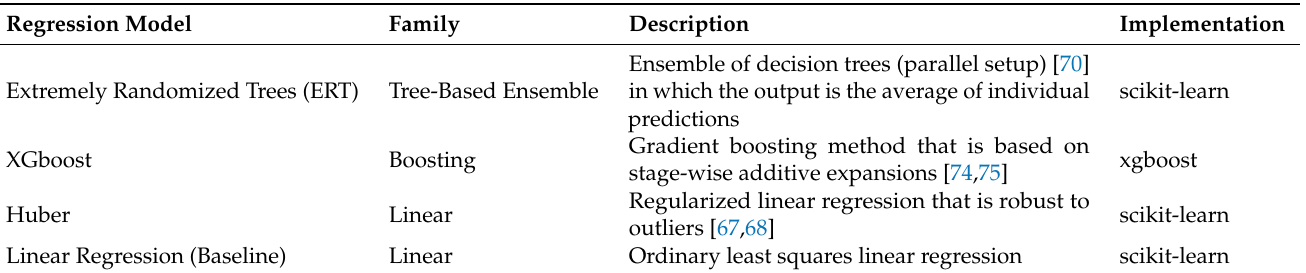
Table 2. A description of the models that were evaluated. The implementations were standardized Python modules.